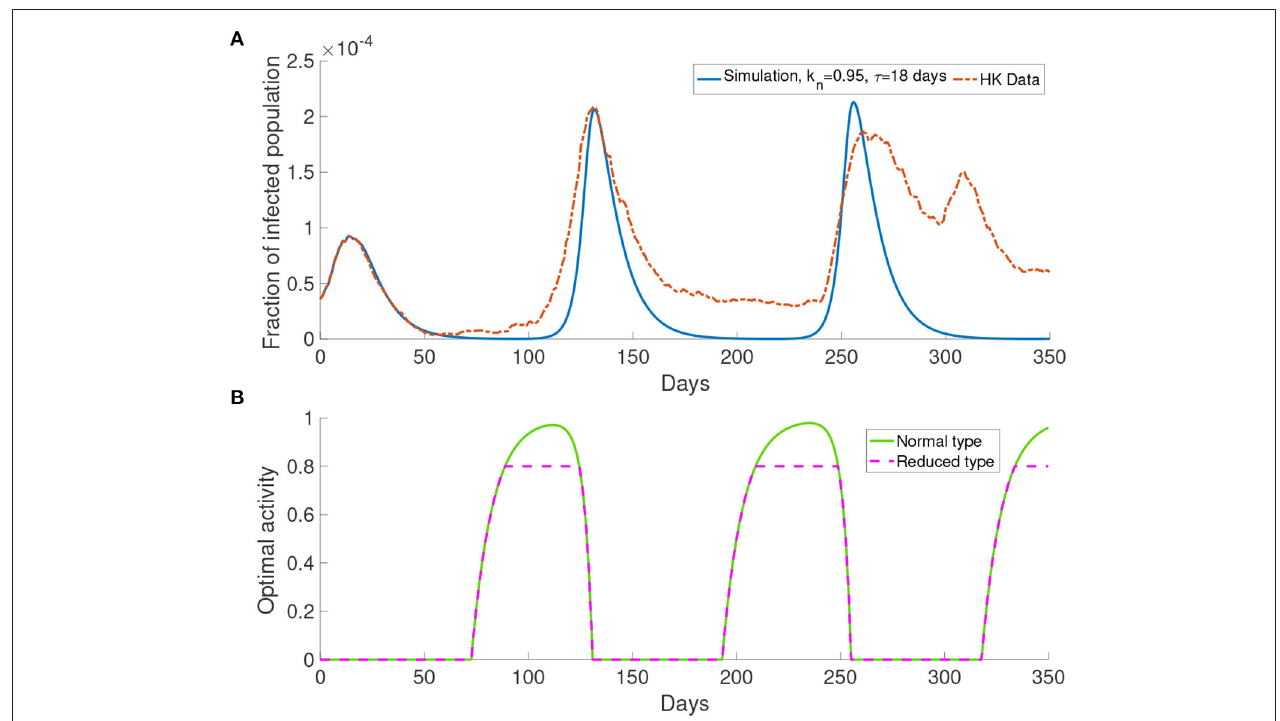
FIGURE 7 | The simulation result with M = 1 and transmission rates in the form of Equations (17) and (18). (A) The comparison of data and the simulation. (B) The corresponding optimal activity for different types. Normal activity type and reduced activity type are the same except in the three intervals of behavioral change. They are from around day 75 to day 175, from around day 180 to day 250 and from around day 320 to day